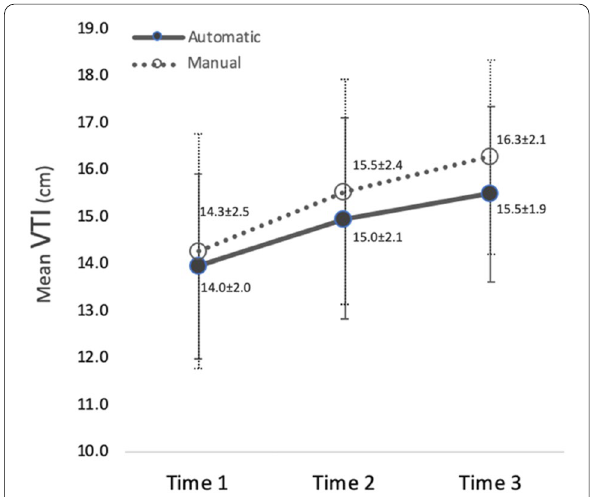
Fig. 3 Physiologic changes in VTI during testing represented as mean measurements of both automatic and manual methods in three consecutive time